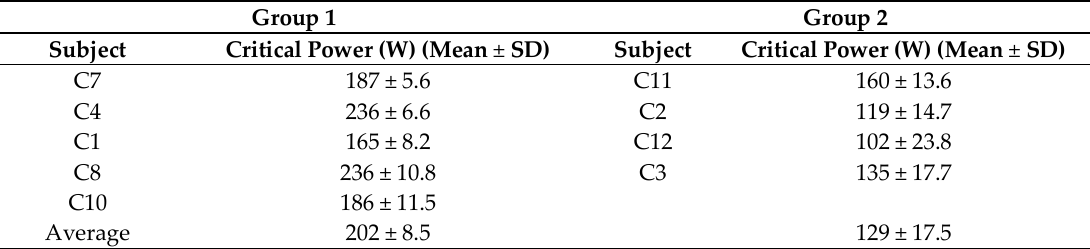
Table 1. Average and standard deviation of final 30 s of 3-min